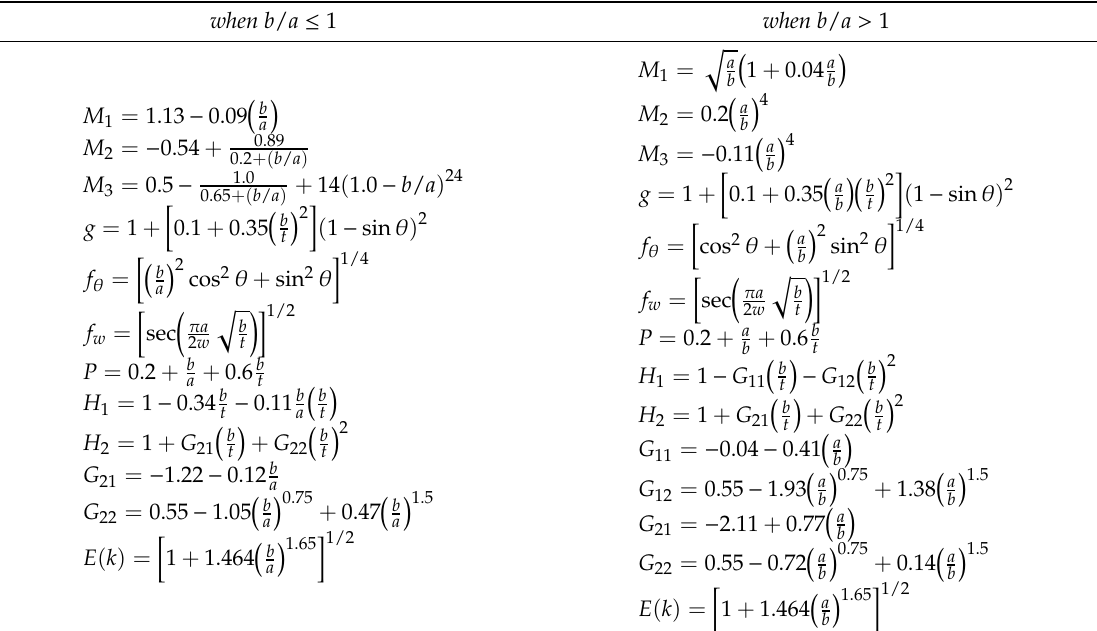
Table 3. Empirical formula of the